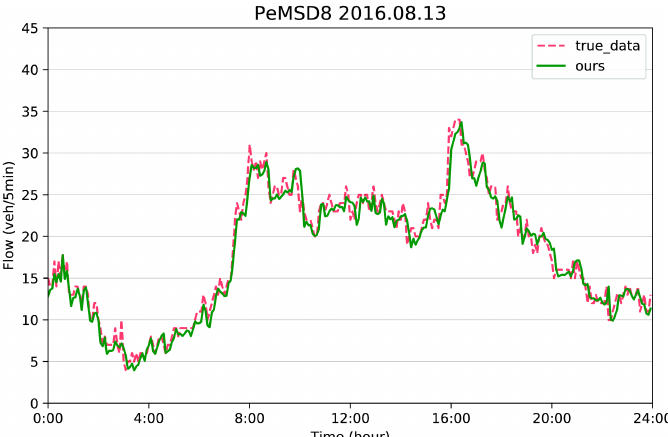
Figure 9. Prediction results for the working day in PeMSD4.